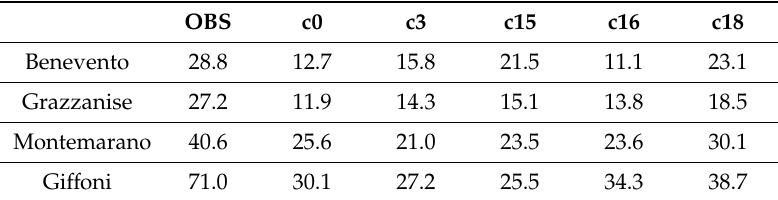
Table 9. Daily precipitation values (mm) for 6 November 2019 for specific ANCE stations, for observational value and model data (selected configurations).